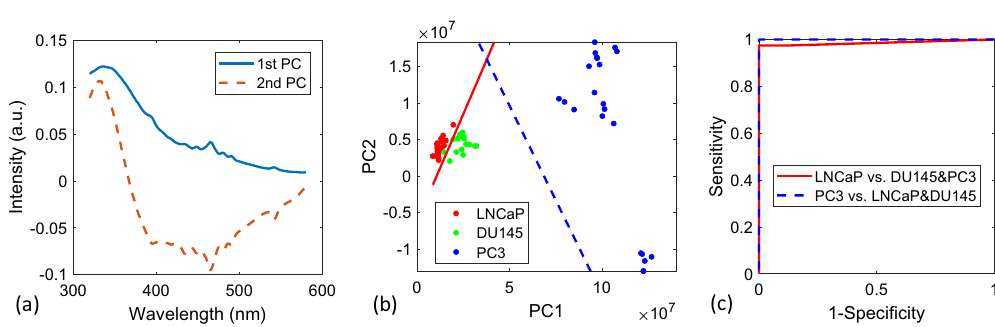
Figure 2. ( a ) Overlay of the first two extracted PCs. ( b ) Scatterplot of the first two PC scores for each NFL spectrum. The solid line separates the least advanced cell line (LNCaP) from the more advanced (DU145 and PC-3) and the dashed line shows the SVM boundary between the cell line possessing highest aggression (PC-3) and the two lowest (LNCaP and DU145). ( c ) The corresponding ROC curves for classifications with